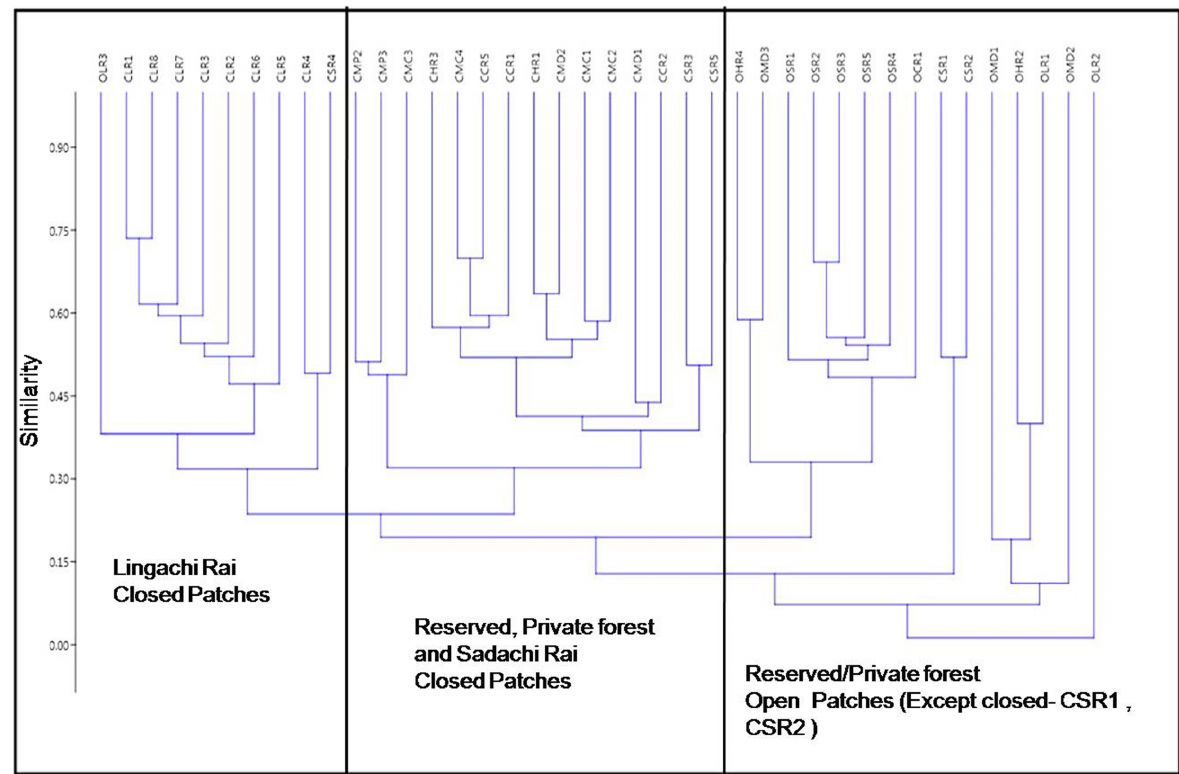
Figure 4. Bray-Curtis similarity plot based on species composition.